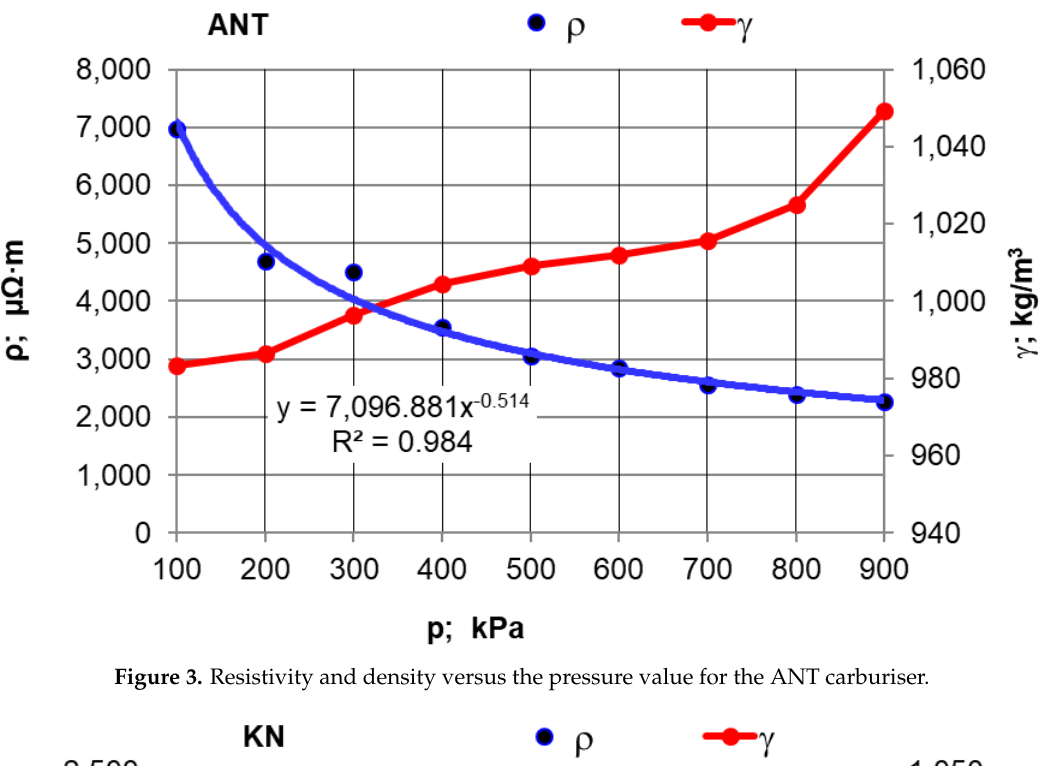
Figure 3. Resistivity and density versus the pressure value for the ANT carburiser.